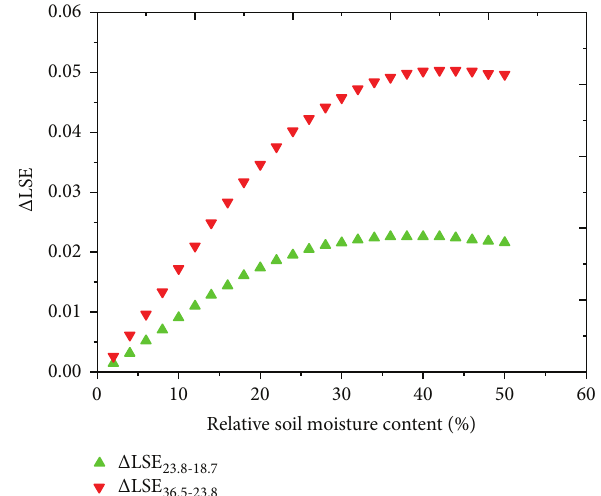
Figure 1: LSE differences at adjacent frequencies (18.7 and 23.8 GHz and 23.8 and 36.5 GHz) versus increasing relative soil moisture